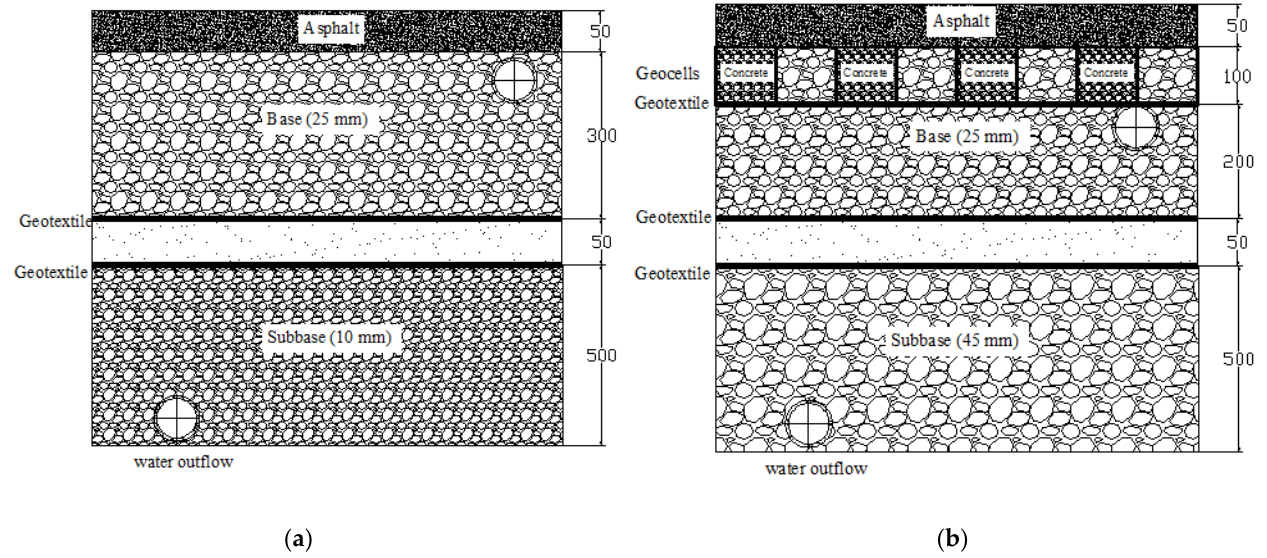
Figure 1. Porous asphalt pavements: ( a ) unreinforced; ( b ) reinforced with geocell composite.